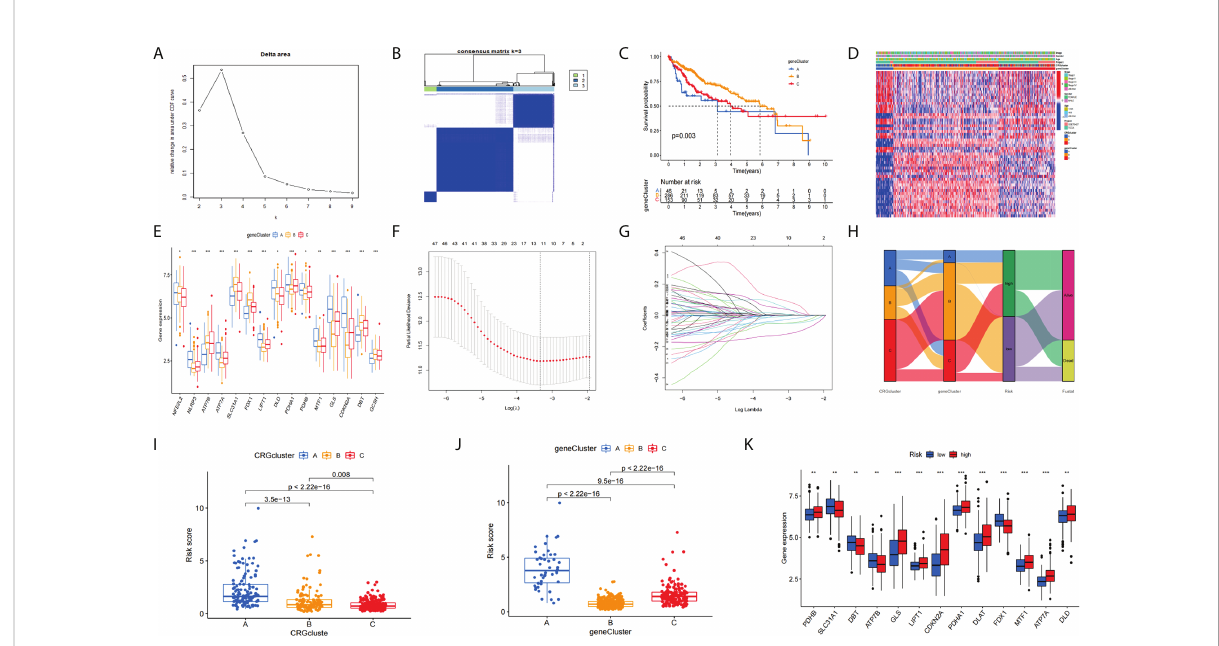
FIGURE 6 Clustering analyses of the signature. (A) The cumulative distribution function based on the sign indicated that the optimal number of subtypes was 3. (B) Concordance matrix of subtypes. (C) K-M survival curve of the three clusters. (D) A complex heat map illustrated the expression patterns. (E) Expression of CRGs between cluster A, cluster B, and cluster C (H) Ggalluvial shows the construction of the prognostic model. (F, G) LASSO regression analyses for screening LASSOSigGenes. Boxplots indicate the differences in risk scores in the CRG cluster (I) and the gene cluster (J) .The differential analysis of CRGs expression (K) . *p<0.05, **p<0.01,